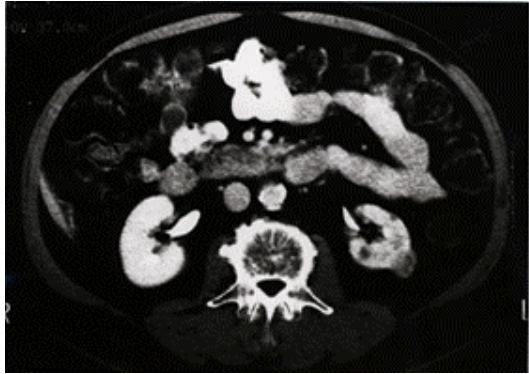
FIGURE 1a. Preoperative CT revealing 2 cm. solid lower pole left renal mass.